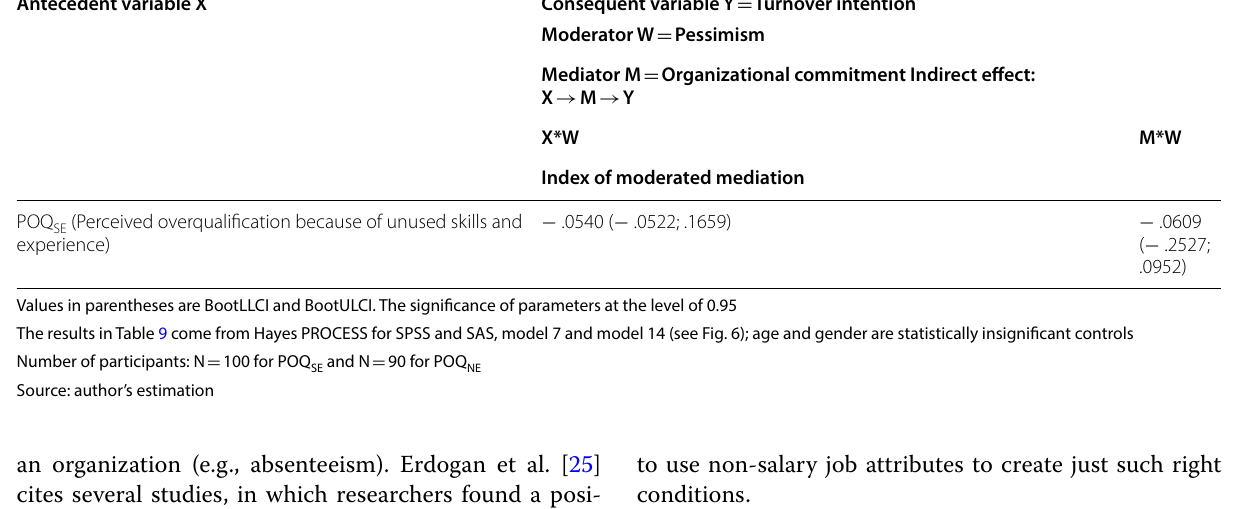
( Perceived overqualification because of unused skills and experience) on Turnover SE